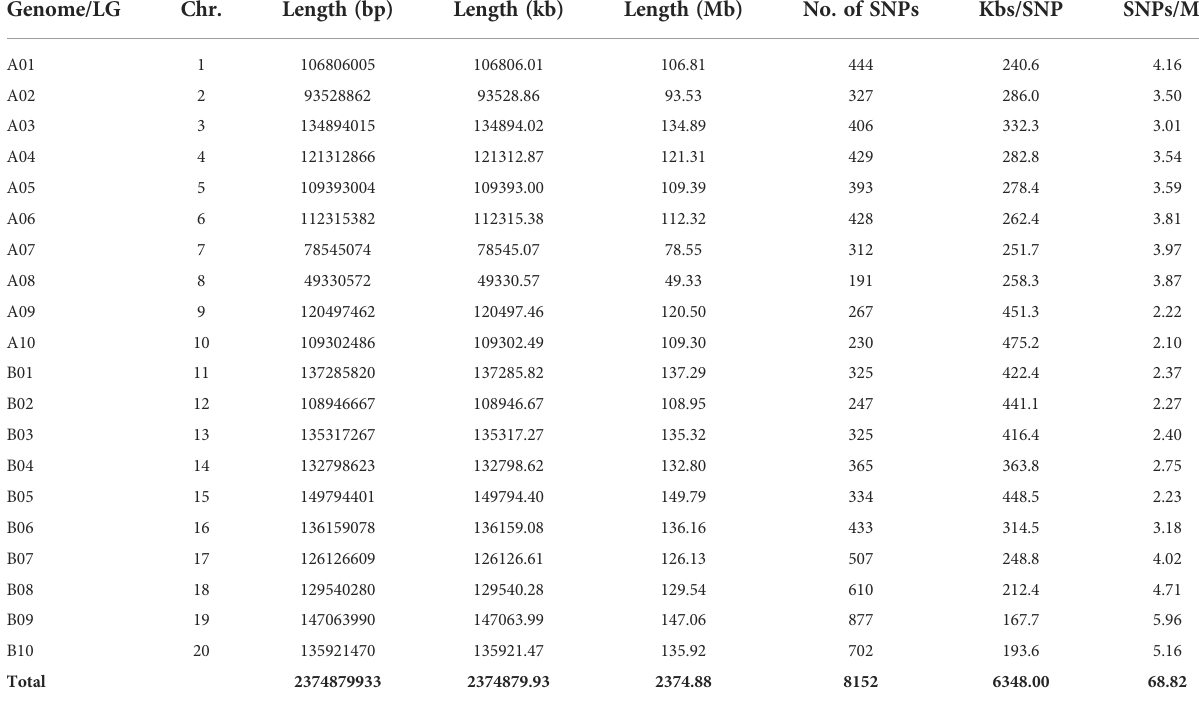
TABLE 2 Distribution of single nucleotide polymorphism (SNP) markers between A and B sub-genomes of groundnut (chromosome) of the studied population. Genome/LG